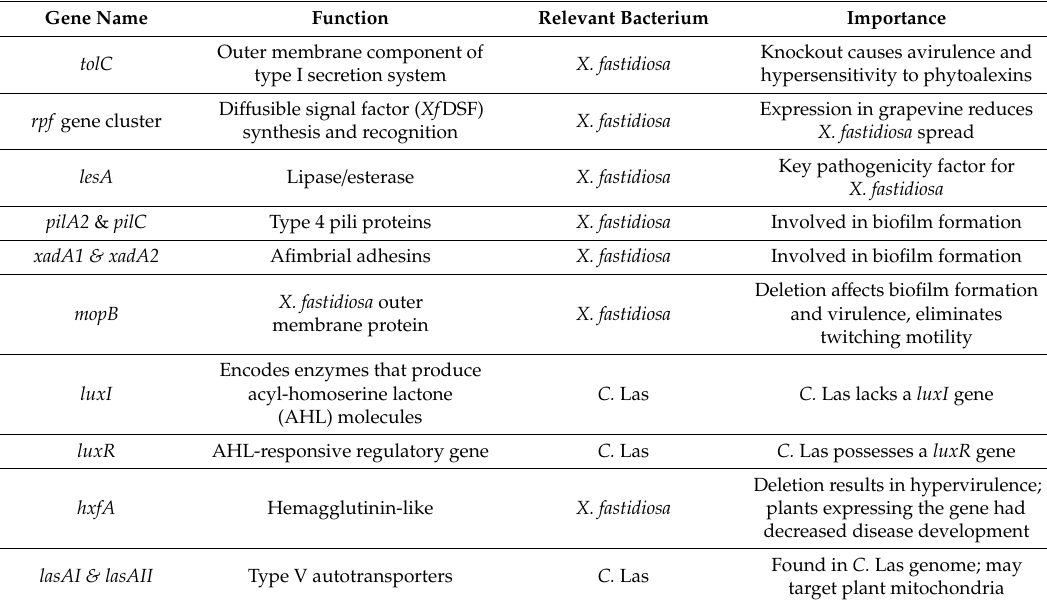
Table 3. Description of bacterial genes referenced in